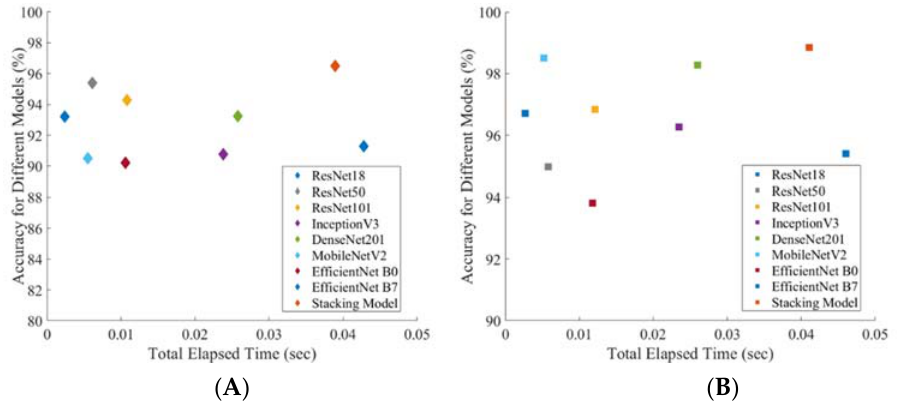
Figure 6. Accuracy vs inference time plot for binary classification using ( A ) symptomatic cough sound spectrograms, and ( B ) asymptomatic cough sound spectrograms.